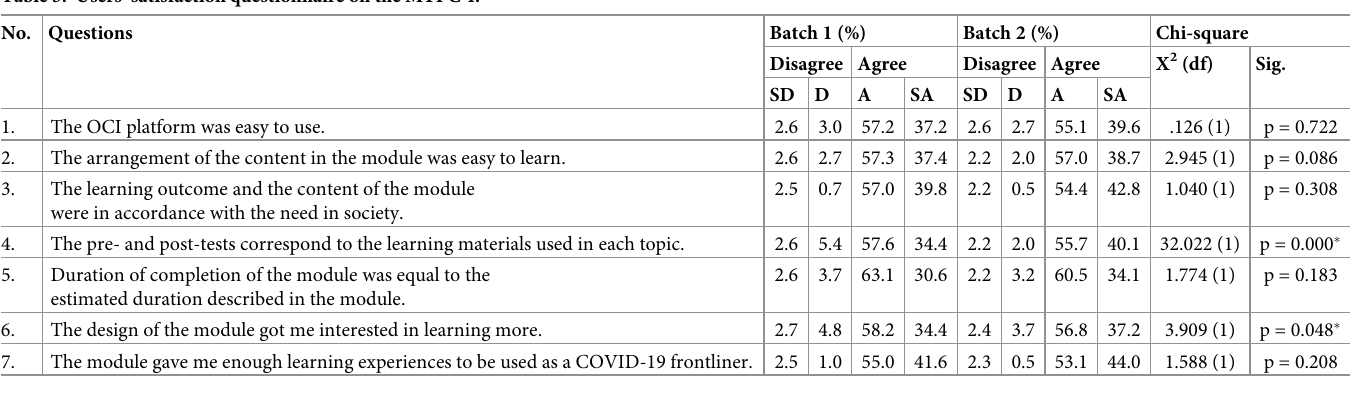
Table 3. Users’ satisfaction questionnaire on the